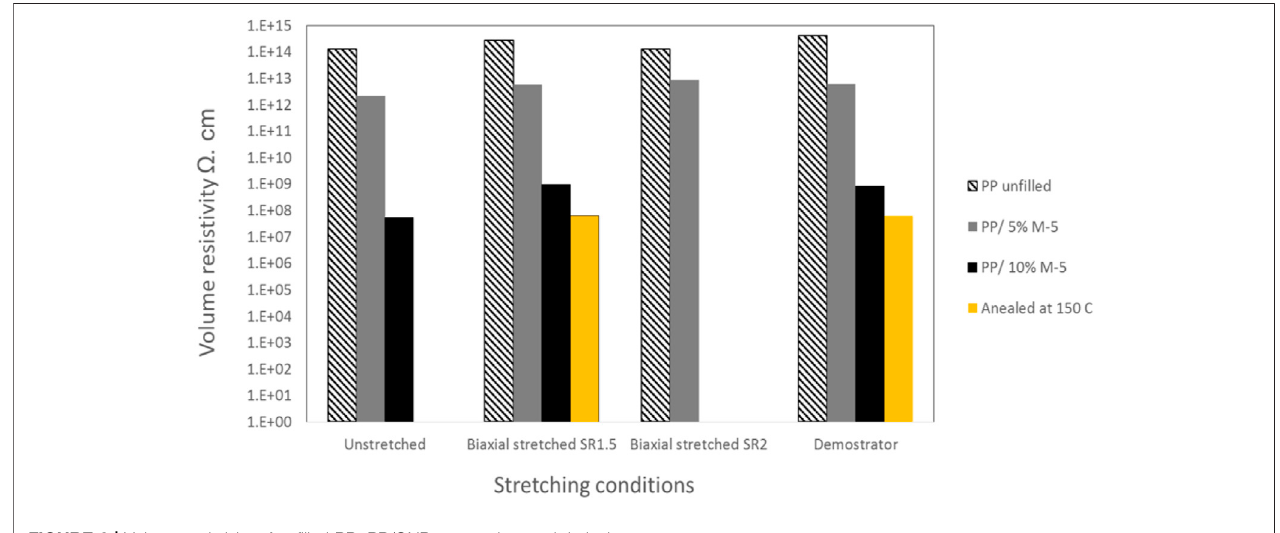
FIGURE 3 | Volume resistivity of un fi lled PP, PP/GNP composites and their demonstrator parts.